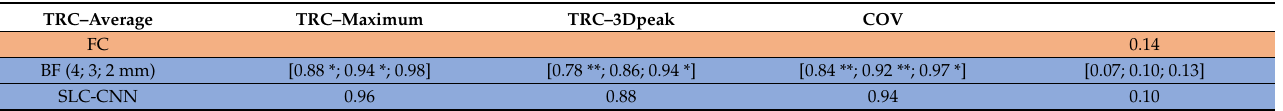
Table A2. Overview of the performance of the BF and the SLC-CNN on the external test 89 Zr- rituximab PET scans from the Ingenuity TF PET/CT scanner. For the FC (orange), and post-processed (blue) PET scans, the TRC and COV values are shown in each